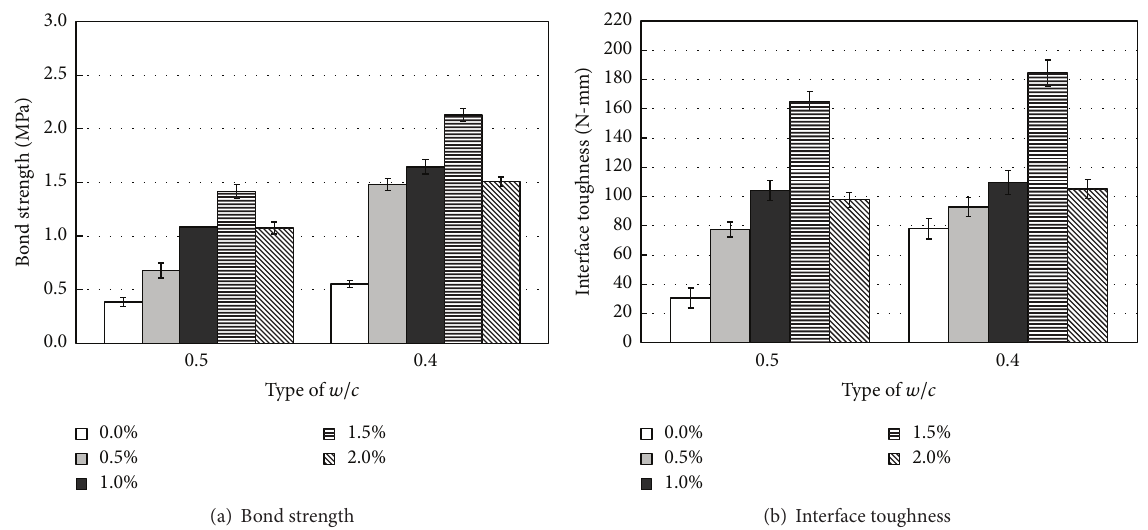
Figure 5: Bond strength and interface toughness of macrosynthetic fiber in LMHFRCCs.